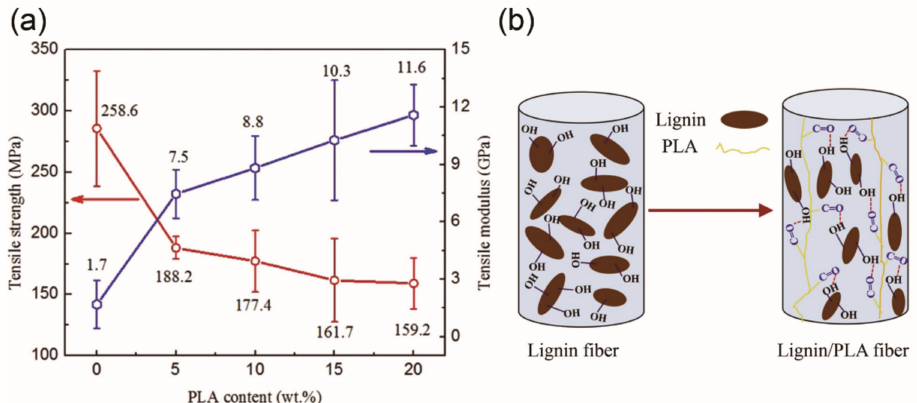
Figure 6. ( a ) Tensile strength and tensile modulus as a function of PLA contents for lignin/PLA- based carbon fibers and ( b ) schematic diagram of the orientation of lignin and lignin/PLA fibers. ( a , b ) Reproduced with permission from [80], copyright 2015